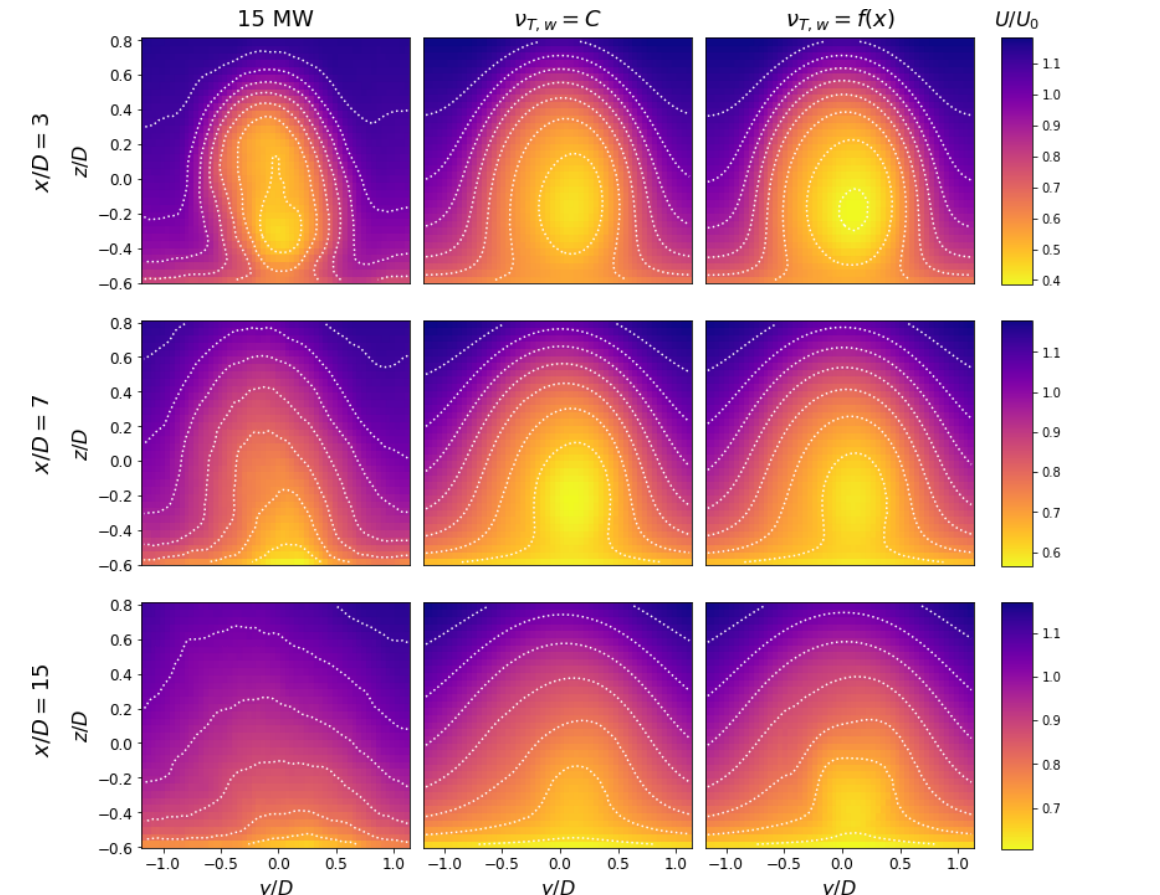
Figure 13. Contours of streamwise velocity in y – z planes for the aligned 15MW turbine. Both formulations capture the near-wake profile but overpredict the far-wake velocity